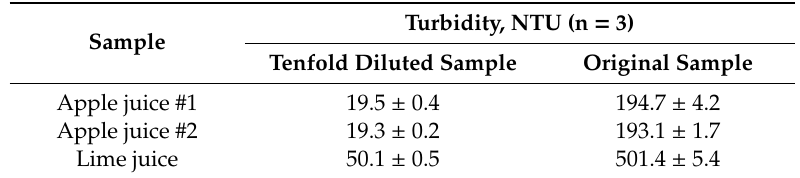
Figure A3. Calibration graph for turbidity in NTU using standard solutions of formazine. Table A2. Measured turbidity values in NTU of cloudy fruit juice samples from the calibration graph in Figure A2.